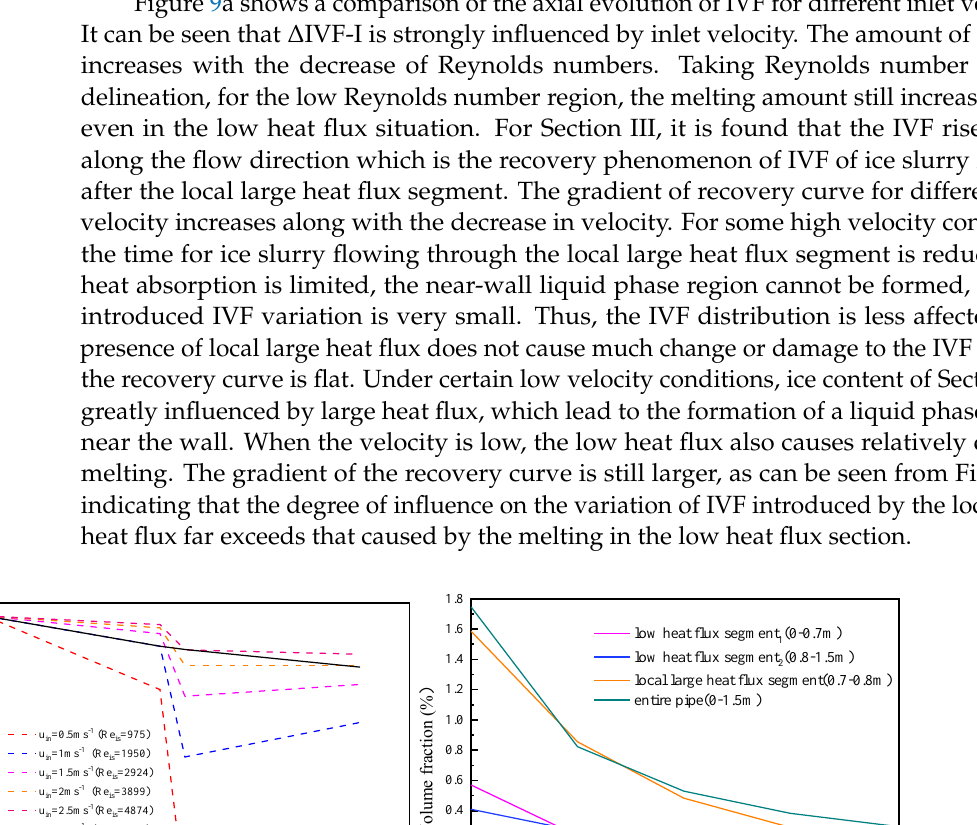
Figure 8. Distribution of IVF with local large heat flux value of 40 kW/m 2 at z = 0.